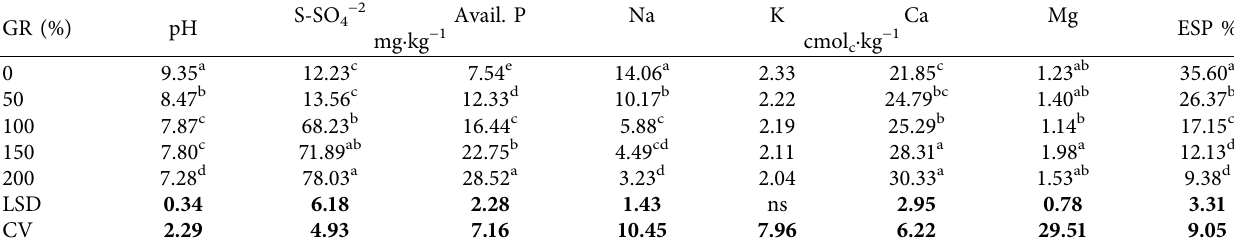
Table 4: Some selected chemical properties of sodic soils after the leaching of PG amended soils. S-SO 4 − 2 Avail. GR (%) pH